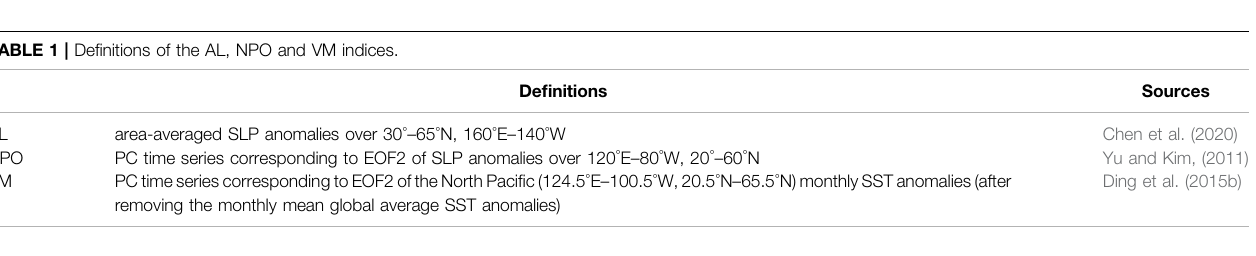
TABLE 1 | De fi nitions of the AL, NPO and VM indices. De fi nitions Sources